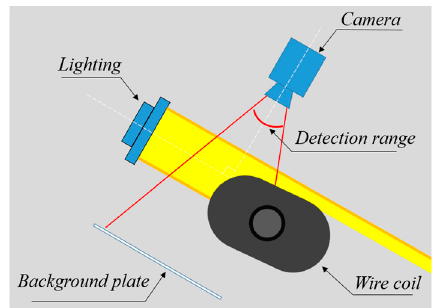
Figure 3. Installation structure of camera and light source.